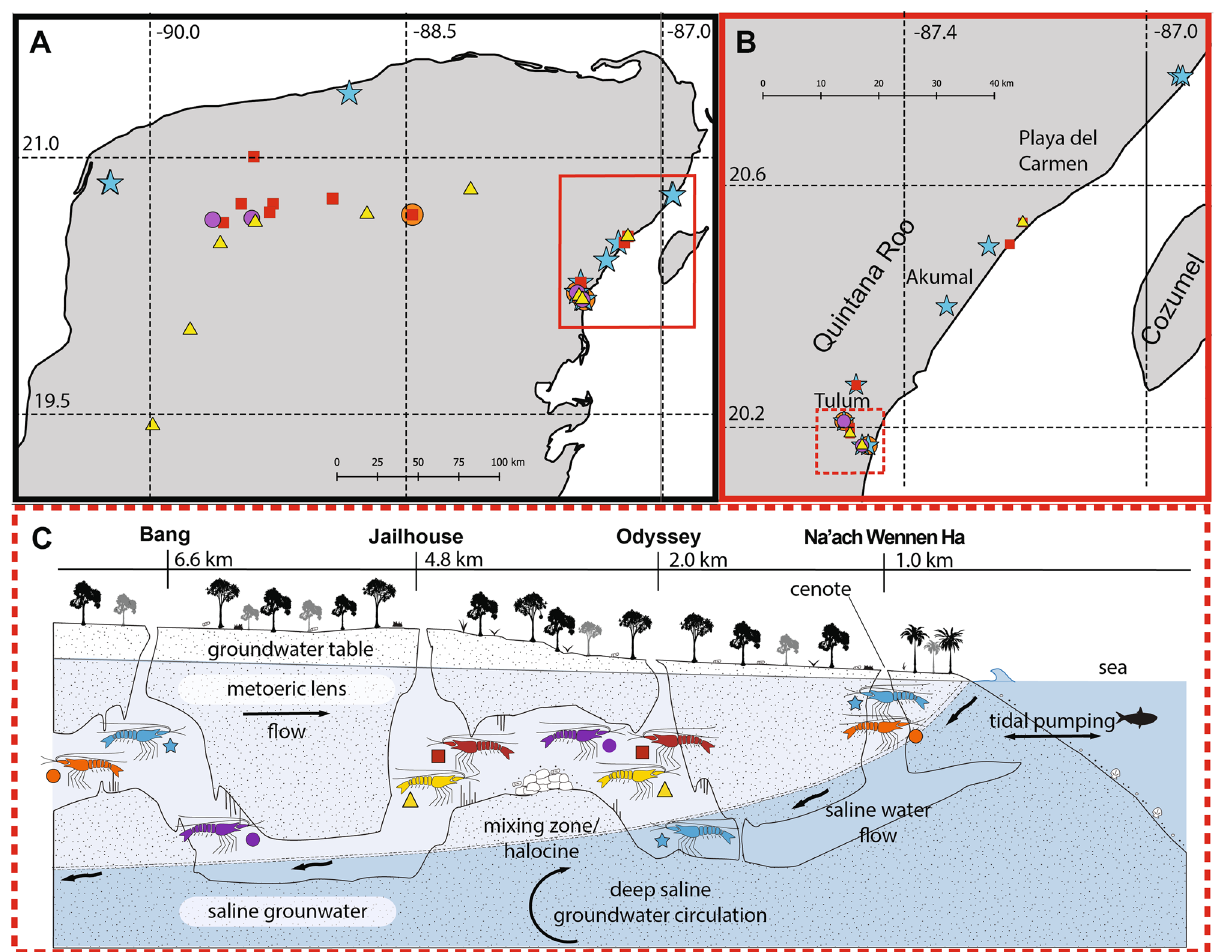
Figure 5. Geographic distribution of Typhlatya spp. included in this study. ( A ) Sampling distribution of Typhlatya spp. (Yucatán Peninsula); ( B ) sampling distribution of Typhlatya spp. (Quintana Roo State, QRS); ( C ) hypothetical cave profile of the Ox Bel Ha system (QRS) and schematic sampling distribution of the five species identified in this study, collected by salinity layer. Shrimp marked with an asterisk indicate unknown salinity values. Colored symbols indicate species identification: Typhlatya pearsei = yellow, triangle; Typhlatya mitchelli = red, square; Typhlatya dzilamensis = blue, star; Typhlatya sp. A = purple, circle; Typhlatya sp. B = orange, circle. Cave profile ( C ) adapted from Brankovits et al. 11 and modified by LB and EB. Maps were made in QGIS using metadata from Natural